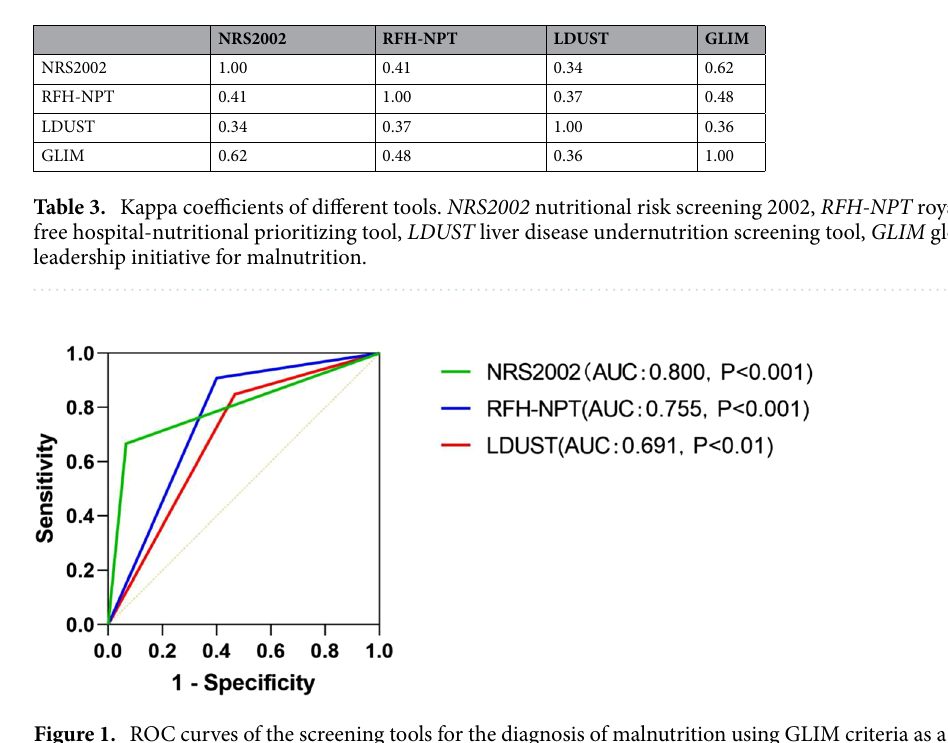
Figure 1. ROC curves of the screening tools for the diagnosis of malnutrition using GLIM criteria as a